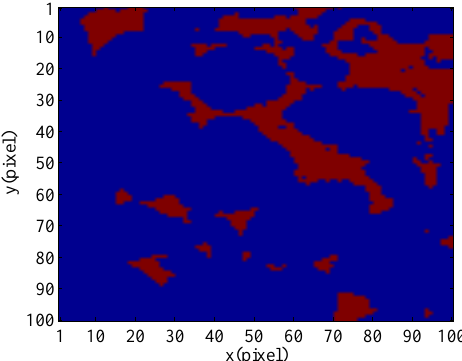
Figure 3. One layer of digital rock. The red part is pore and the blue part is grain.